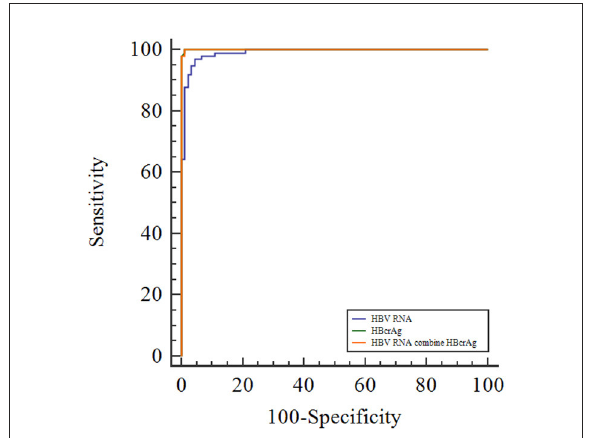
FIGURE3 Receiver operating characteristic curve showing the diagnostic value of serum HBV RNA and HBcrAg concentrations in HBeAg-positive patients with CHB